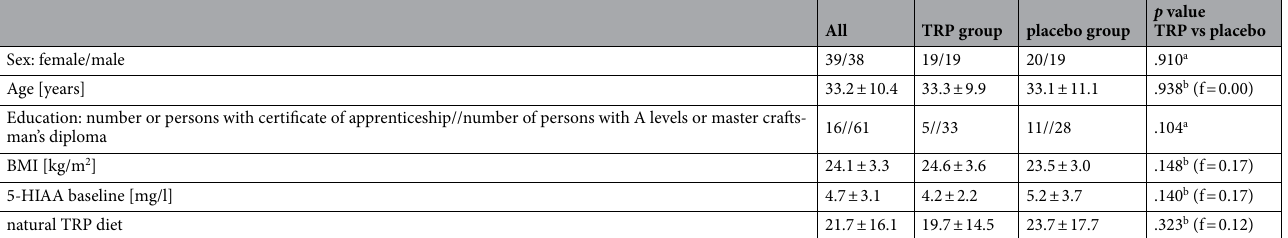
Table 1. Descriptive variables (number of cases or mean ± SD) of the 77 participants with data from at least two time points; for 5-HTP analyses all participants received 200 mg 5-HTP at t1 or t2, only order differed; only half of participants received 500 mg L-TRP enriched bars for four weeks (the other half got normal/ placebo protein bars). 5-HIAA: 5-hydroxyindoleacetic acid raw value was related to individual creatinine values and afterwards standardized to group mean creatinine (1045 mg/l); normal range: 2–9 mg/l. Natural TRP diet: values refer to the sum of units (rough equivalents for consumed amount of TRP rich food items) during 28 days of natural diet (see methods and supplement for details). a Chi 2 test; b univariate ANOVA.